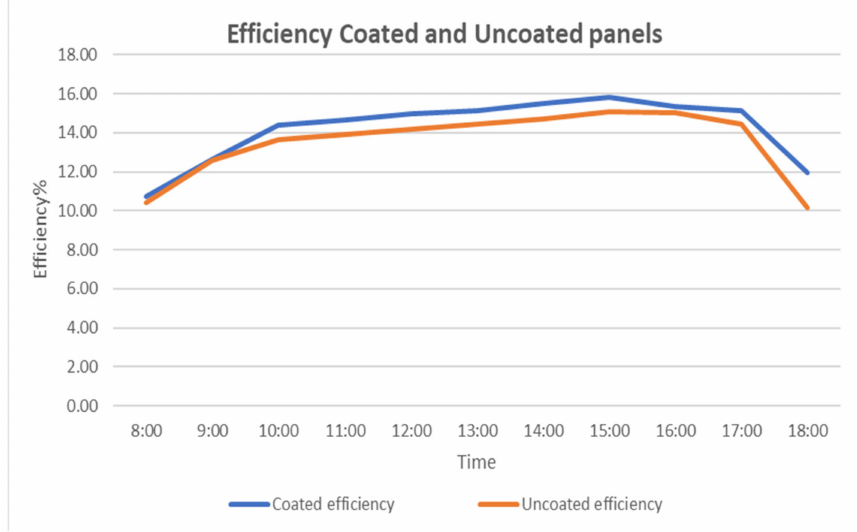
Figure 13. Hourly efficiency for coated and uncoated panels.